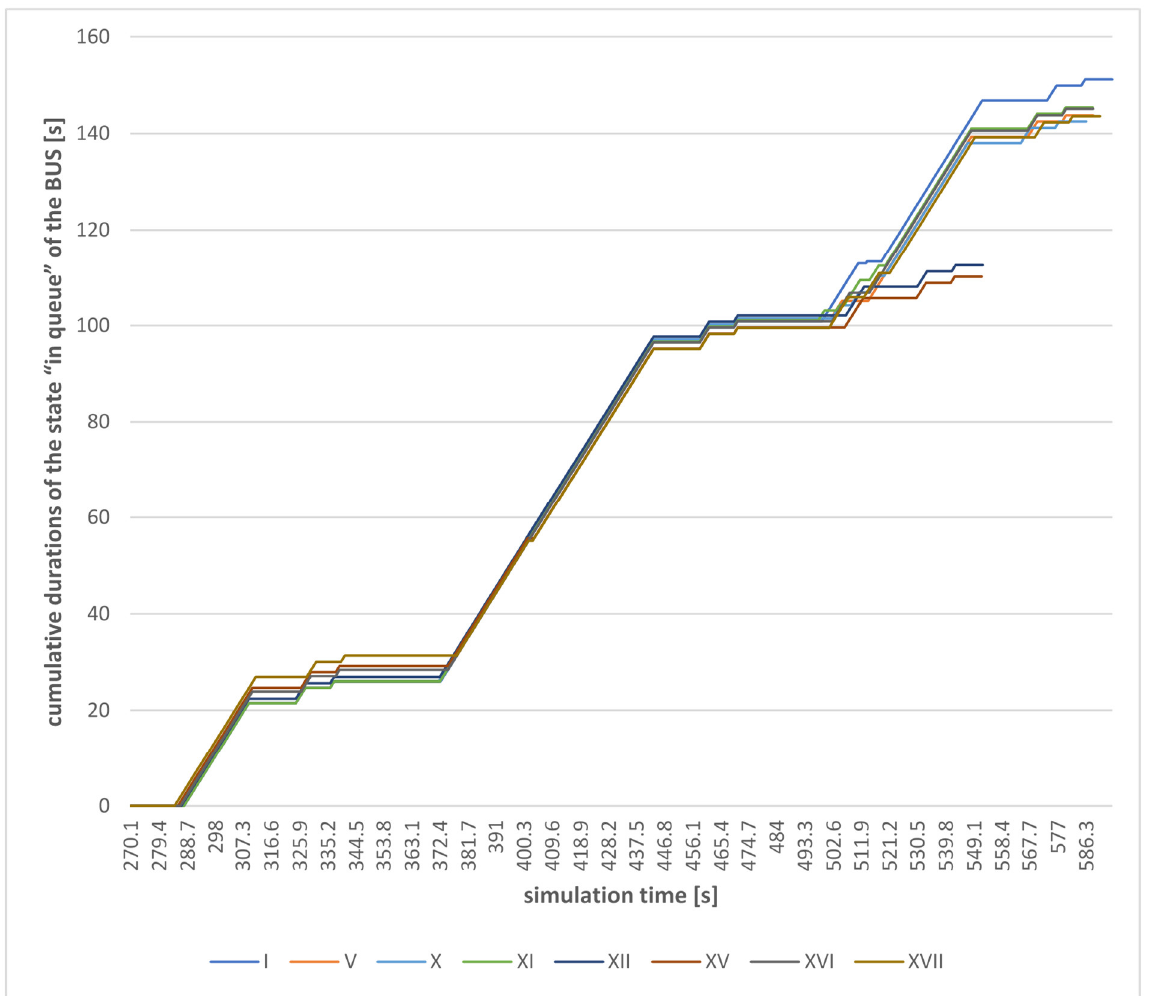
Figure 9. Durations of the state “in queue” for Bus 81 heading towards the Sikawa district in selected scenarios.